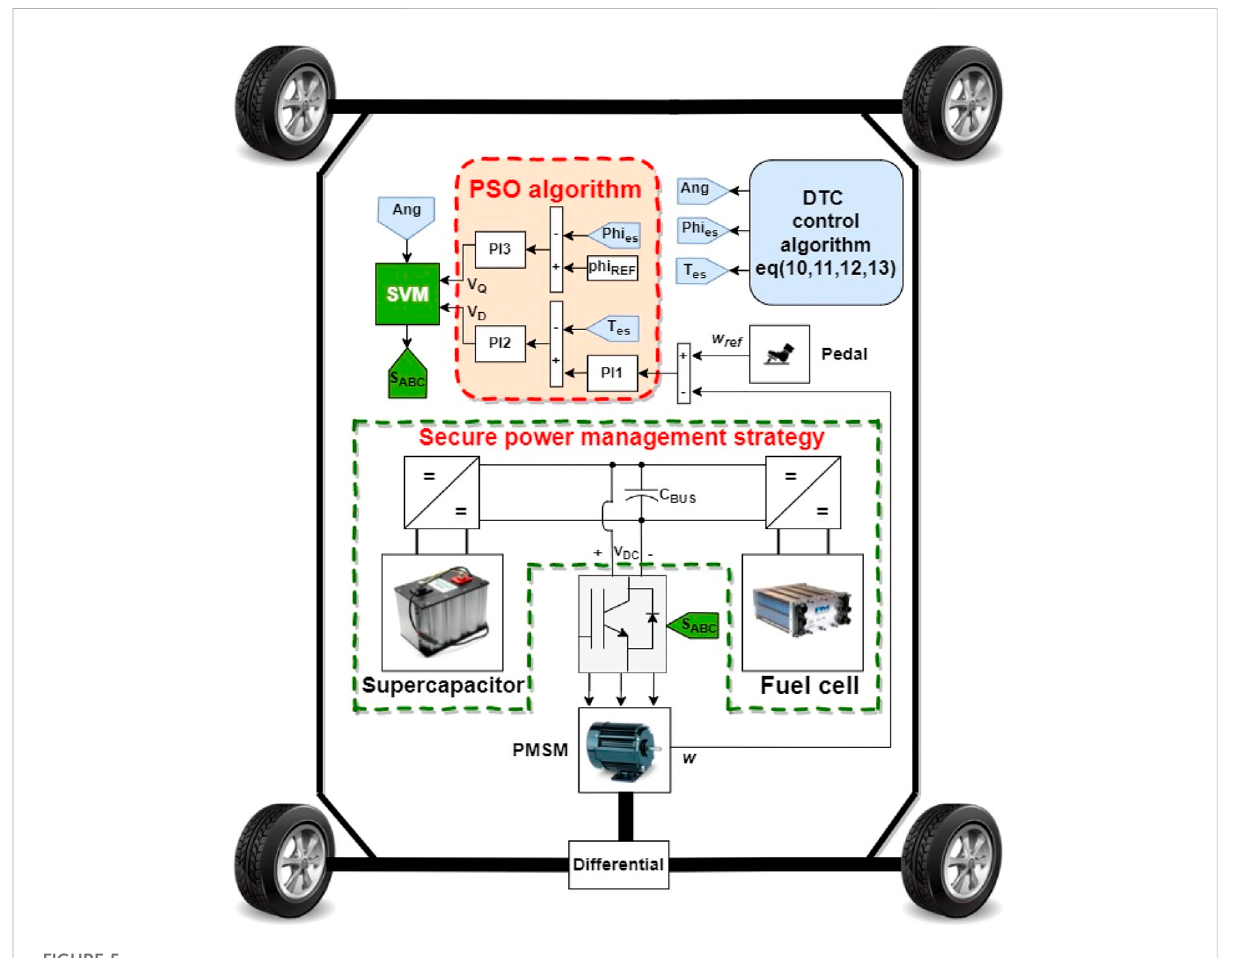
FIGURE 5 Top view of SC-FC